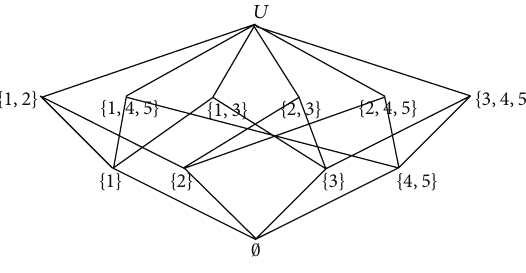
Figure 1: The geometric lattice of ( L (𝑀( C )),⊆)